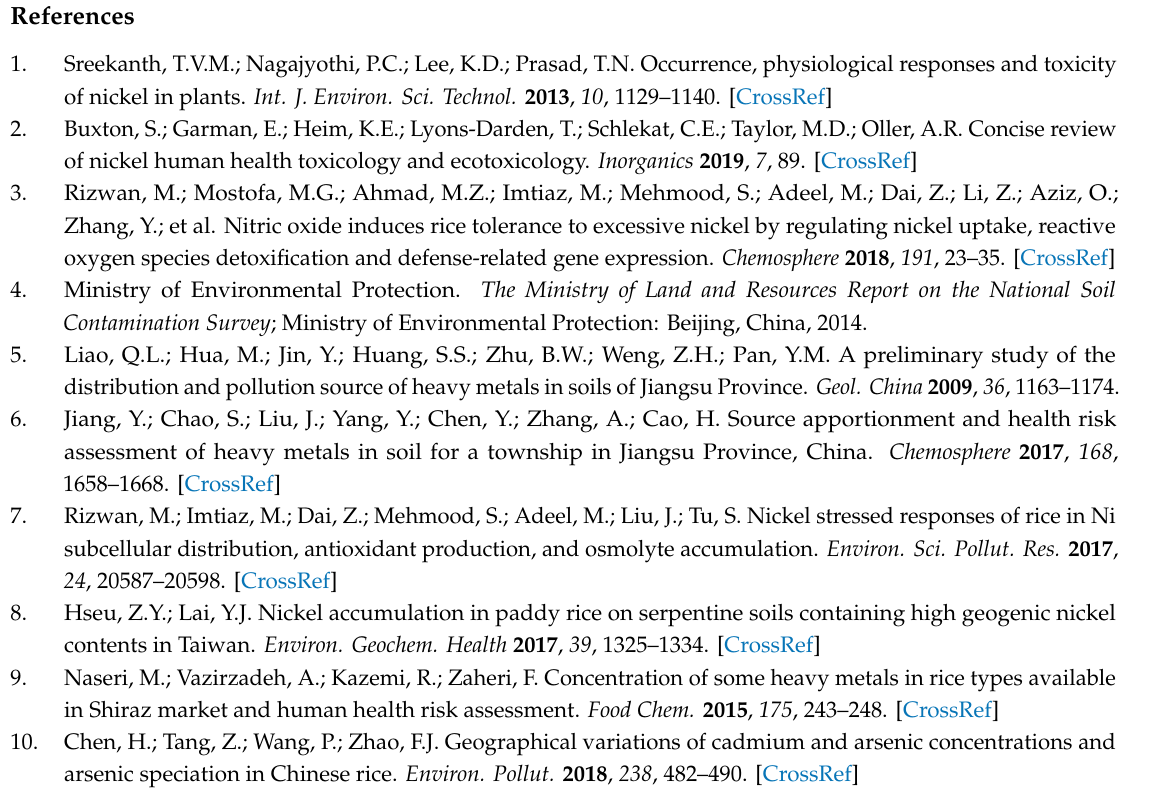
Figure S1: Nickel (Ni) bioconcentration factors in the rice shoots (A) and roots (B). The bioconcentration factor (BCF) of Ni from culture medium to shoots or roots were calculated as: BCF = Cshoots Ni or roots Ni / CNi in culture medium, Figure S2: RDA ordination diagrams of the relationships between accumulation and translocation of Ni and multi-element (Si, P, Fe, and Mn) in 20 lowest Ni-accumulating rice cultivars, Figure S3: The biomass (dry weights) of rice seedlings after exposure to 0 and 10 µ mol · L − 1 Ni for 3 days under hydroponics condition, Figure S4: The amount of nutrients in rice shoots and roots with or without addition of 10 µ mol · L − 1 Ni for 3 days under hydroponics condition, Figure S5: The amount of nutrients in rice shoots and roots with or without addition of 10 µ mol · L − 1 Ni for 3 days under hydroponics condition, Table S1: Pearson correlation coe ffi cients between accumulation and translocation of multi-element (Si, Ni, P, Fe, and Mn) in 20 lowest Ni-accumulating rice cultivars, Table S2: Pearson correlation coe ffi cients between accumulation and translocation of multi-element (Si, Ni, P, Fe, and Mn) in 20 highest Ni-accumulating rice